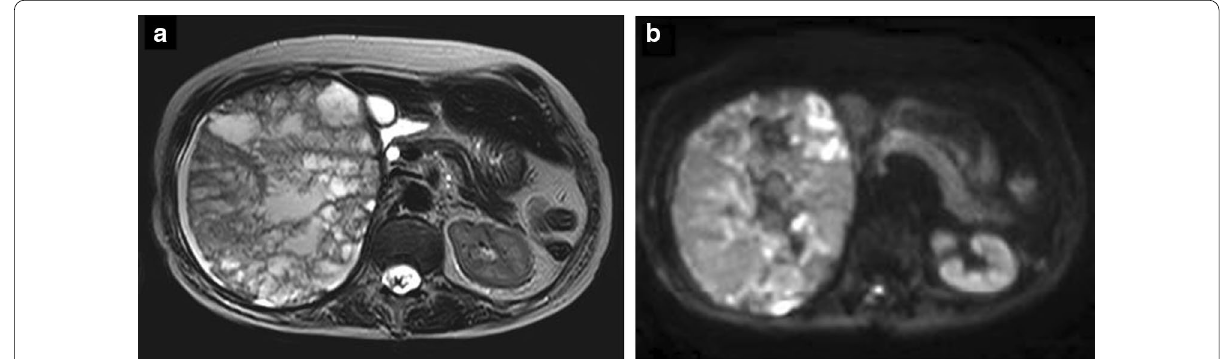
Fig. 3 MRI. a T2-weighted imaging. The inside of the tumor showed a mosaic pattern with a mixture of high and low signals. b Diffusion weighted imaging: b 1000. A high signal was observed predominantly at the tumor margin =